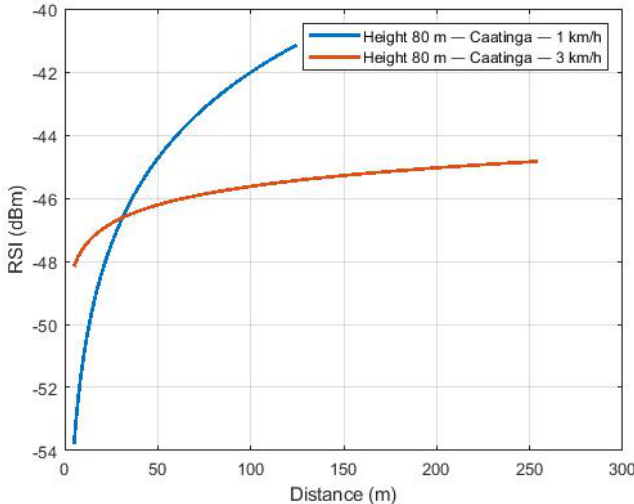
Figure 7. Path loss of flights over the Caatinga.